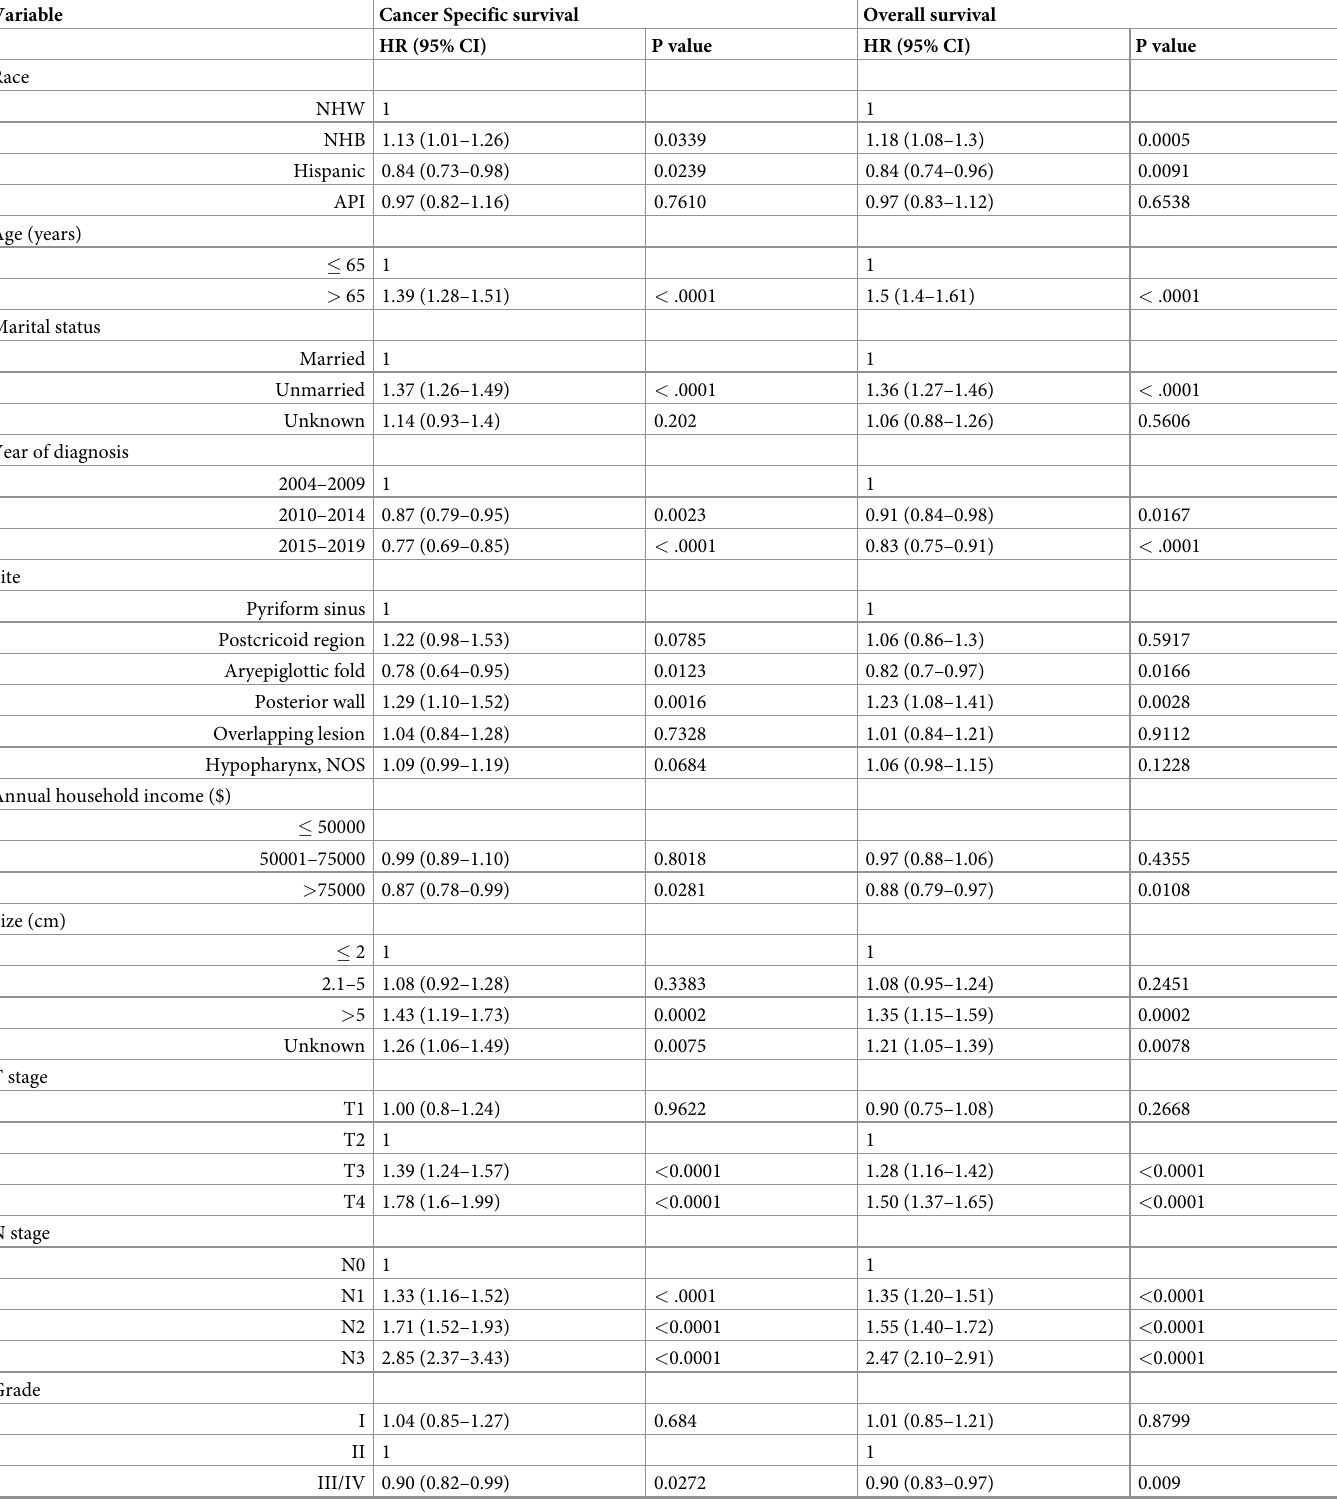
Table 5. Multivariate survival analysis of factors associated with locally advanced hypopharyngeal